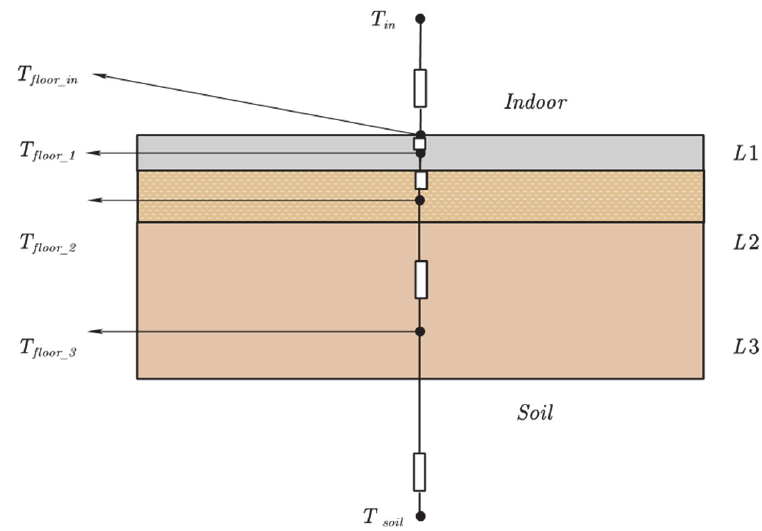
Figure 4. The nodes of floors.